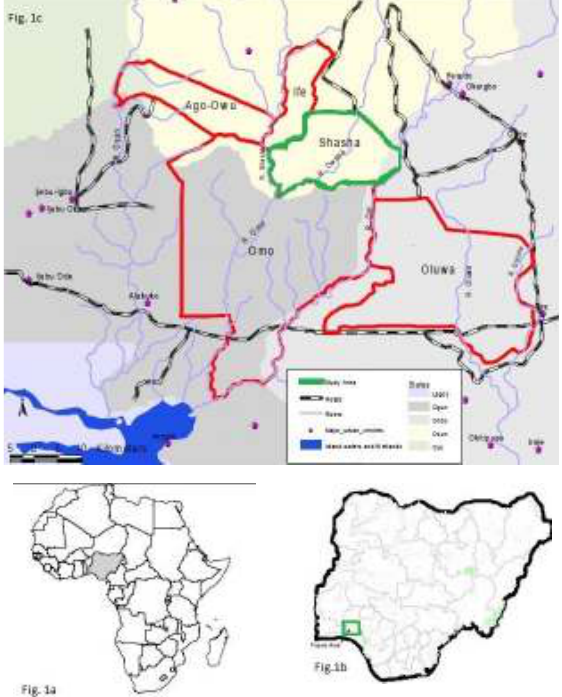
Fig. 1. Map of Africa (Fig. 1a), Nigeria (Fig. 1b) and Shasha forest reserve (Fig.1c). Adapted from Omo-Shasha-Oluwa Initiative in Protected